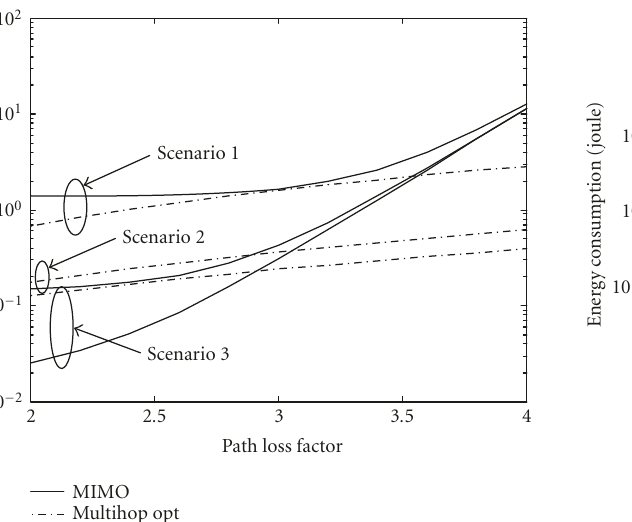
Figure 6: Total energy consumption versus n and D when ρ s = 0 . 01 ( M =